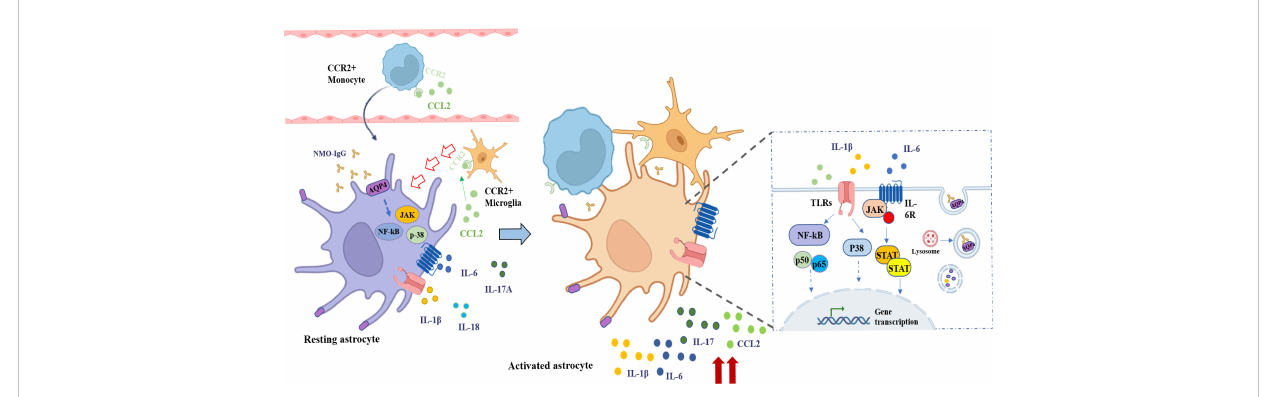
FIGURE 7 The schematic diagram shows the potential role and mechanisms of CCL2 in NMO-IgG-induced damage. The speci fi c binding of NMO-IgG to AQP4 on the cytomembrane of astrocytes activated various intracellular in fl ammatory signaling pathways, for example NF- k B, p38, and JAK/STAT signaling pathways, which could induce the release of several in fl ammatory cytokines and chemokines, such as CCL2, IL-1 b , IL-6, IL-17A, and IL-18. Subsequently, CCL2-derived peripheral CCR2-positive (CCR2 + ) monocytes penetrated the brain or attracted microglia/macrophages migrated toward the lesion focus close to astrocytes in the CNS. The interaction of CCR2 + cells with injured astrocytes could further stimulate the release of in fl ammatory cytokines, forming a positive feedback cascade loop leading to more serious damage to